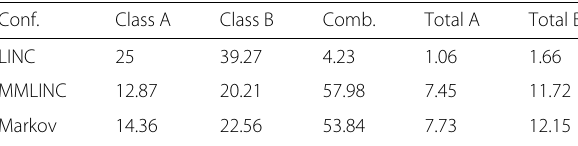
Table 3 Estimated efficiency bounds (%) OFDM 1 MHz bandwidth